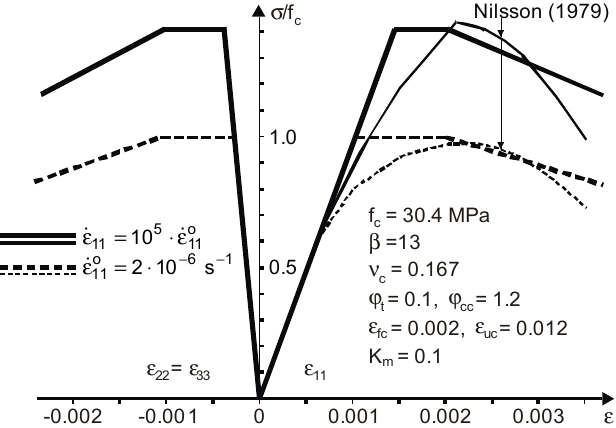
Figure 15. Comparison of the proposed model with Nilsson’s [6] model.